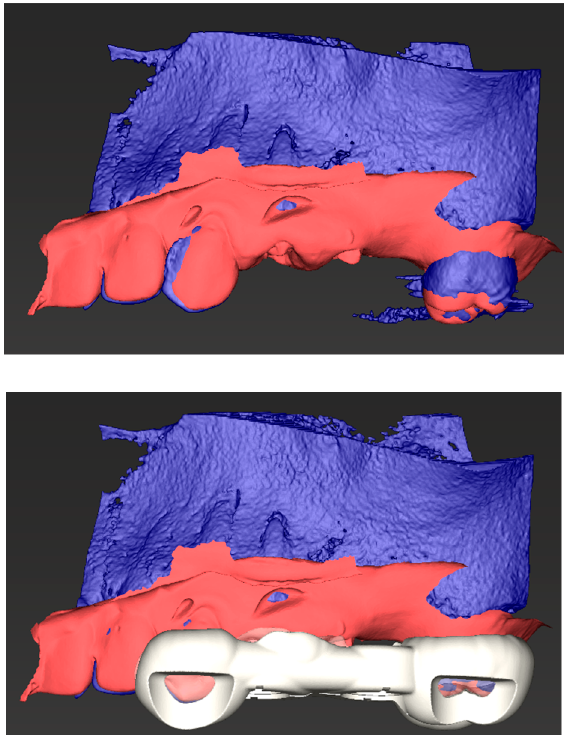
Figure 4. Combined stereolithography (STL) data with Digital Imaging and Communications in (DCM) data ( top image ) and STL exportable/printable surgical guide allowing for precision surgical entry ( bottom image ).